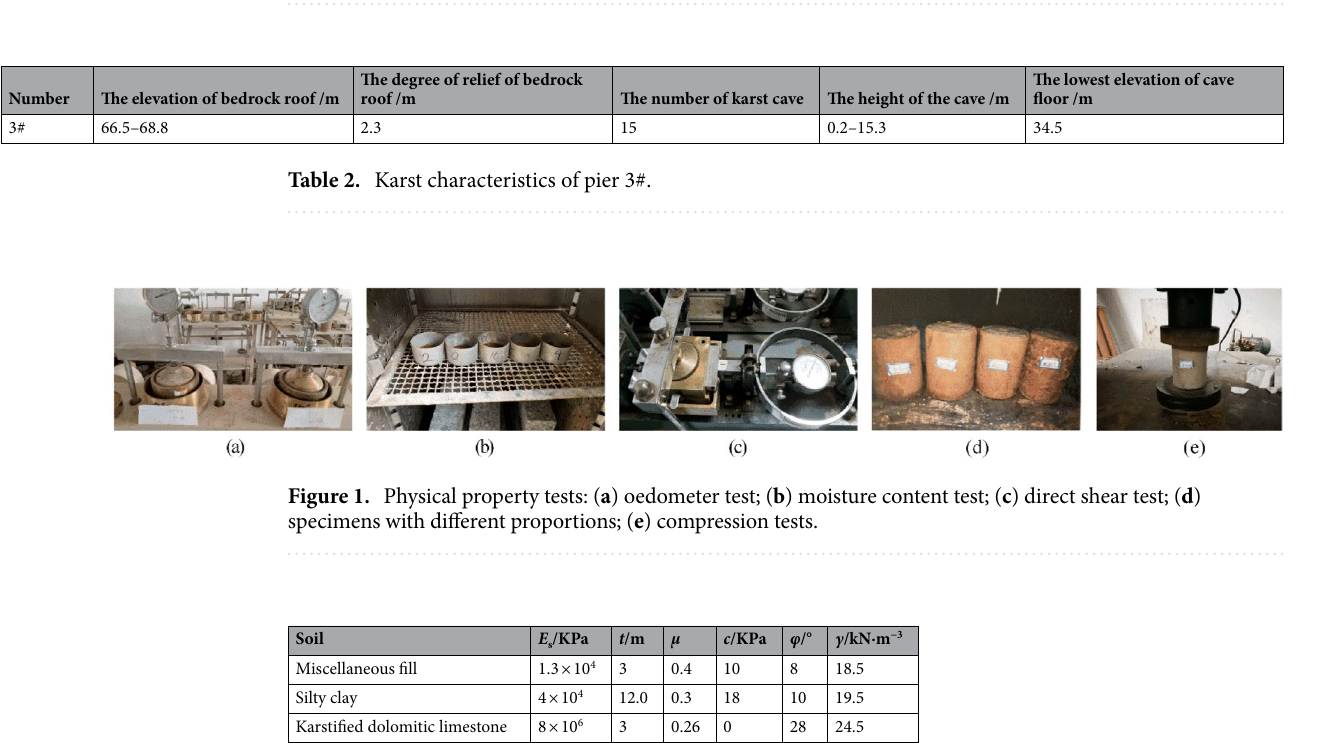
Table 1. Geological conditions.